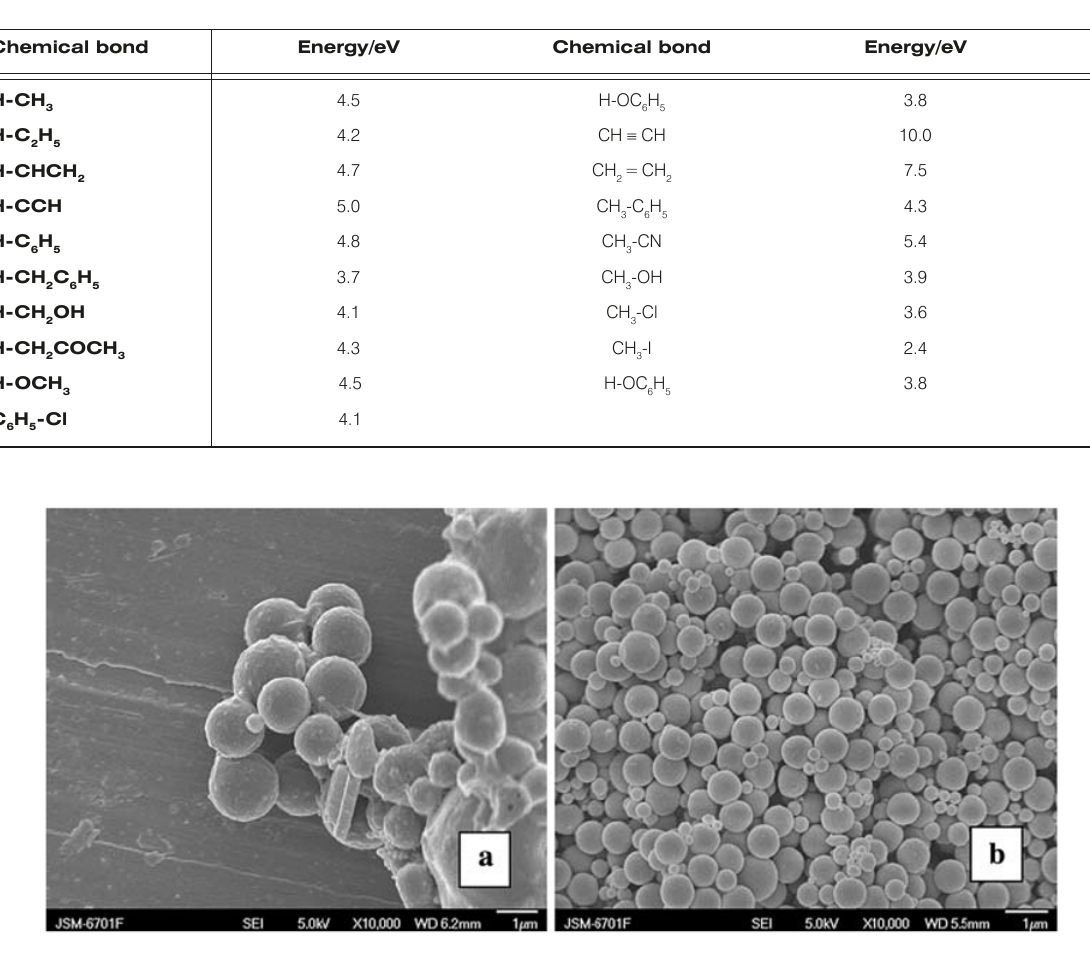
Figure 1. SEM morphologies of PMMA. (a): initiated by AIBN; (b): initiated by GDEP. The other conditions are same. (Adapted from